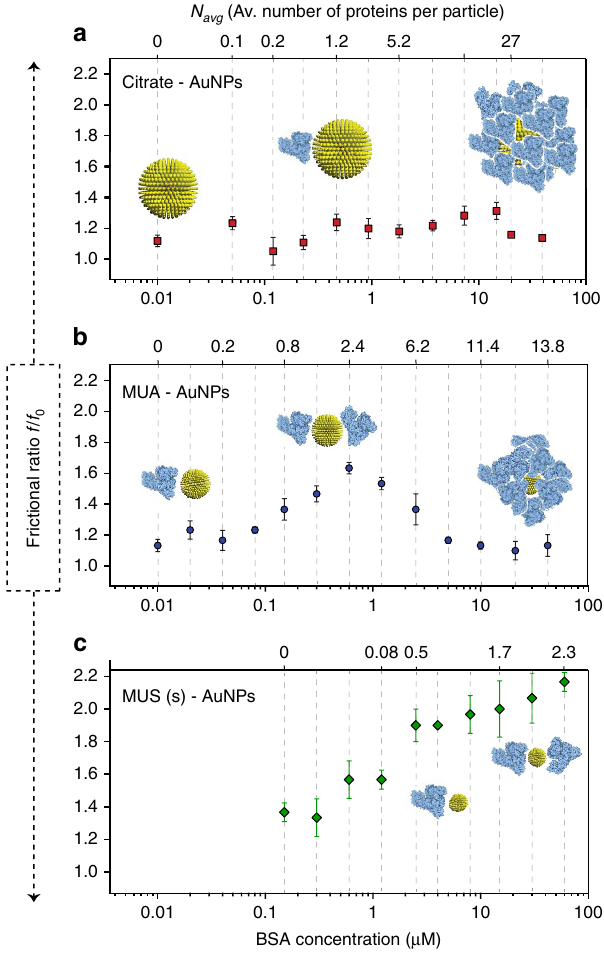
Figure 4 | Anisotropic shape evolution of NP-protein complexes. Plots of frictional ratio versus BSA concentration (bottom x-axis) and N avg (top x- axis) for ( a ) Citrate–AuNPs, ( b ) MUA–AuNPs and ( c ) MUS(s)–AuNPs. Possible arrangements of proteins on a nanoparticle are depicted in the plots to clarify the anistropic change on protein binding. It should be noted that these are only cartoon images and not based on scientific simulation. Error bars represent the standard deviation of three independent measurements from the same batch of